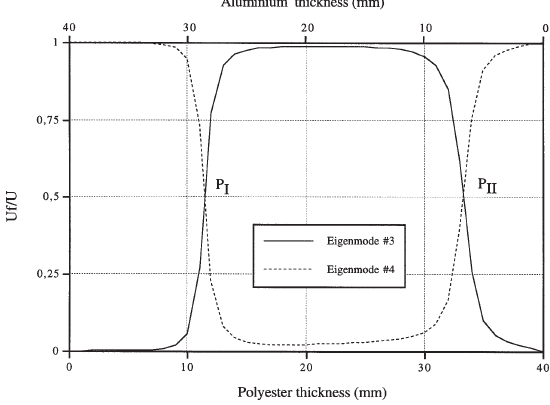
Fig. 1. The effect of thickness distribution on the natural frequencies.